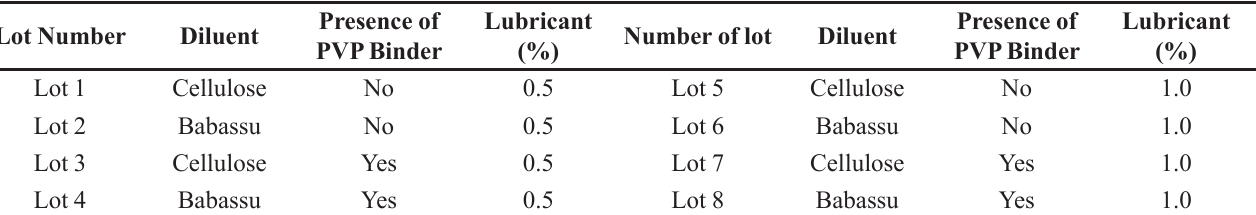
TABLE II - Definition of the composition of the different lots of tablets according to the factors under study (diluent, presence of binder and percentage of